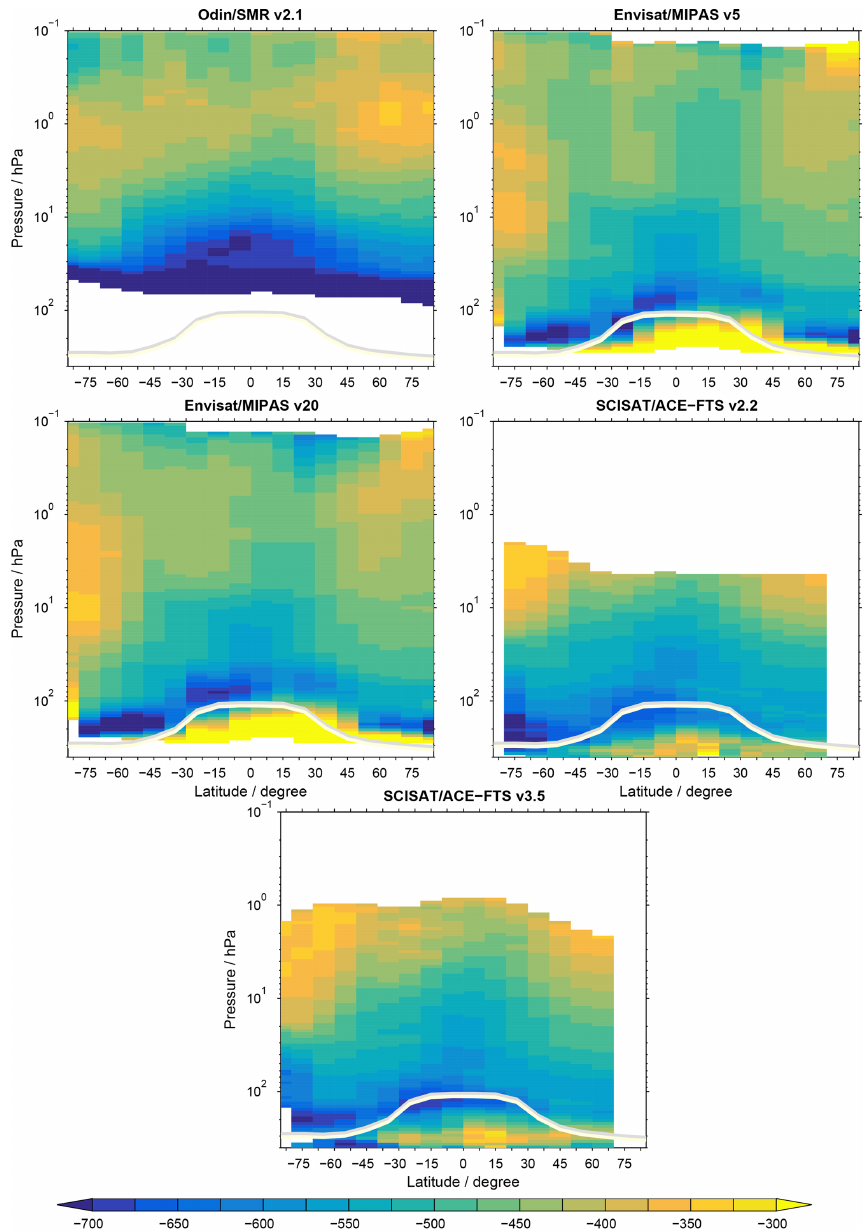
Figure 3. Climatologies of δ D for the five data sets considered in this study and for the JJA